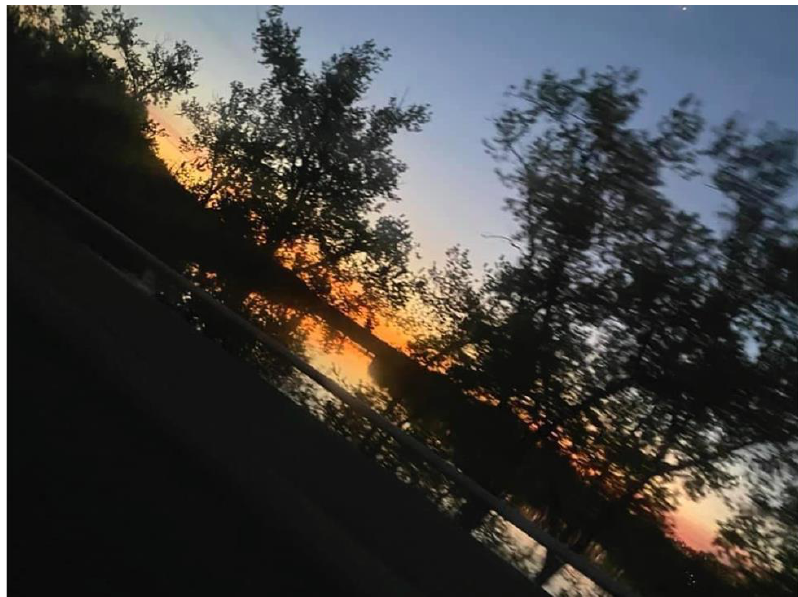
Int. J. Environ. Res. Public Health 2022 , 19 , x FOR PEER REVIEW Figure 12. An encouraging view on the participant’s way to work. Figure 12. An encouraging view on the participant’s way to work.